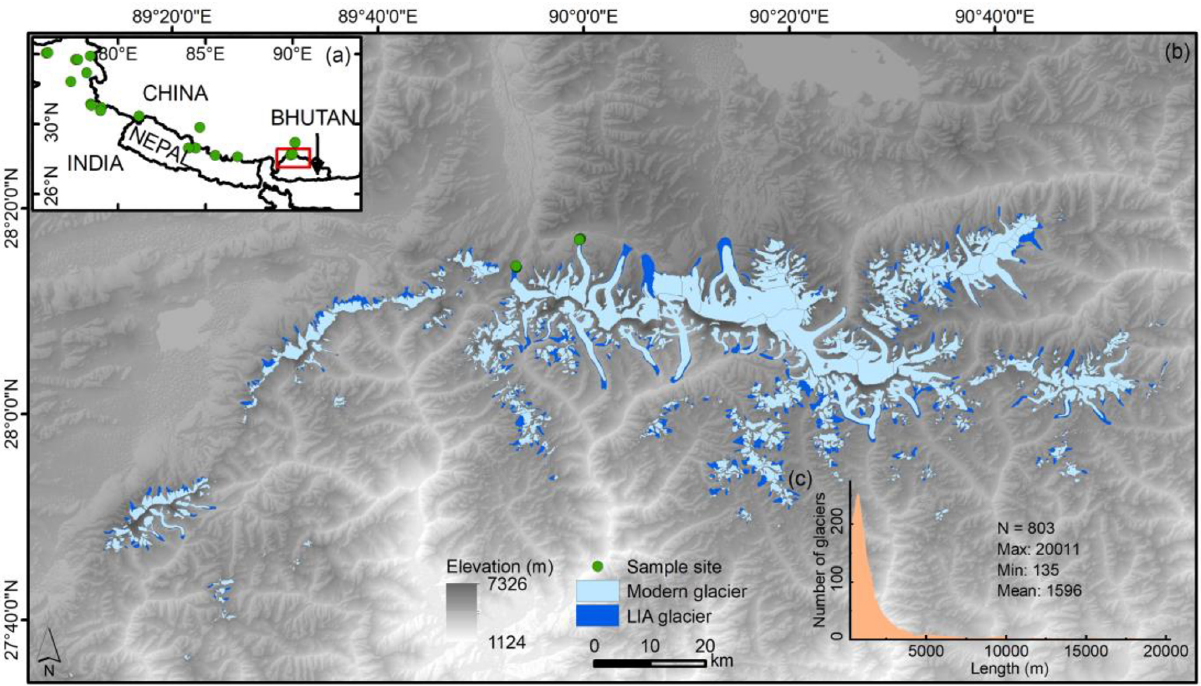
Figure 1. An overview of study area and moraine sites. The red box in (a) shows the location of the study area, and the green circles in (a) display the spatial distribution of the 10 Be exposure dating moraines. The basic information of these moraine sites can refer to Table S1 in the Supplement. (b) The extent of the modern glaciers (in light blue; RGI Consortium, 2017) and LIA glaciers (in navy blue). The background DEM was obtained from the Shuttle Radar Topography Mission (SRTM) 90m Digital Elevation Model v4.1 (Jarvis et al., 2008; http://srtm.csi.cgiar.org/, last access: 17 September 2022). (c) The length distribution of modern